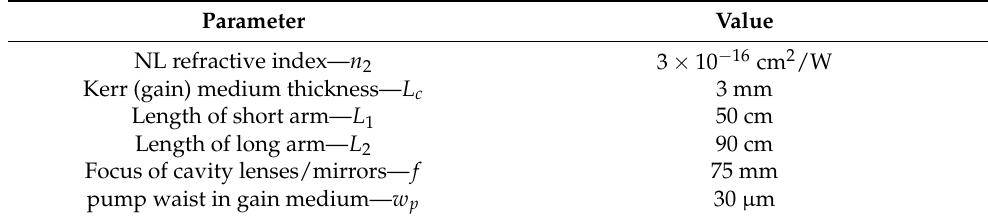
Table 1. Parameter values for the cavity configuration and the Kerr